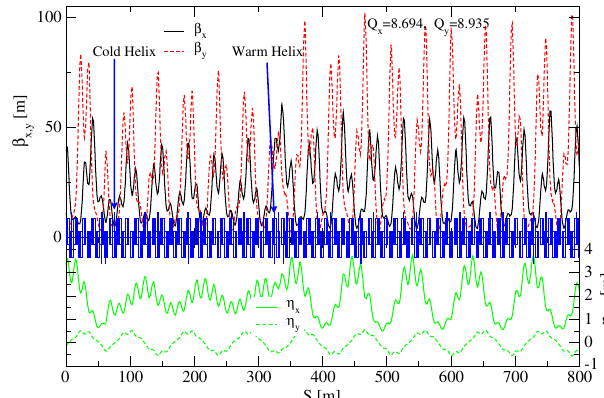
FIG. 11. The beta ( (cid:1) x;y ) and eta ( (cid:2) x;y ) functions along the whole ring of the AGS operating with two helices at beam energy corresponding to G(cid:3) ¼ 5 : 0 . The locations of the cold and warm helices along the ring are indicated by arrows. The values of the horizontal and vertical betatron tunes are also shown on the plot. Note the large value of the (cid:1) y (cid:6) 100 m function as compared to the nominal one of (cid:1) y (cid:6) 23 m shown in Fig. 8. Similarly, the horizontal dispersion function (cid:2) y shows large variation along the ring as compared to that of the nominal AGS shown in Fig. 8. The appearance of the vertical dispersion function indicates beam coupling which is introduced by the 2.1 T cold Fig. 8. In addition, the 2.1 T strength of the cold helix introduces beam coupling which is apparent by the vertical dispersion shown as the green dashed line in Fig. 11. The experimental proof which shows that the vertical